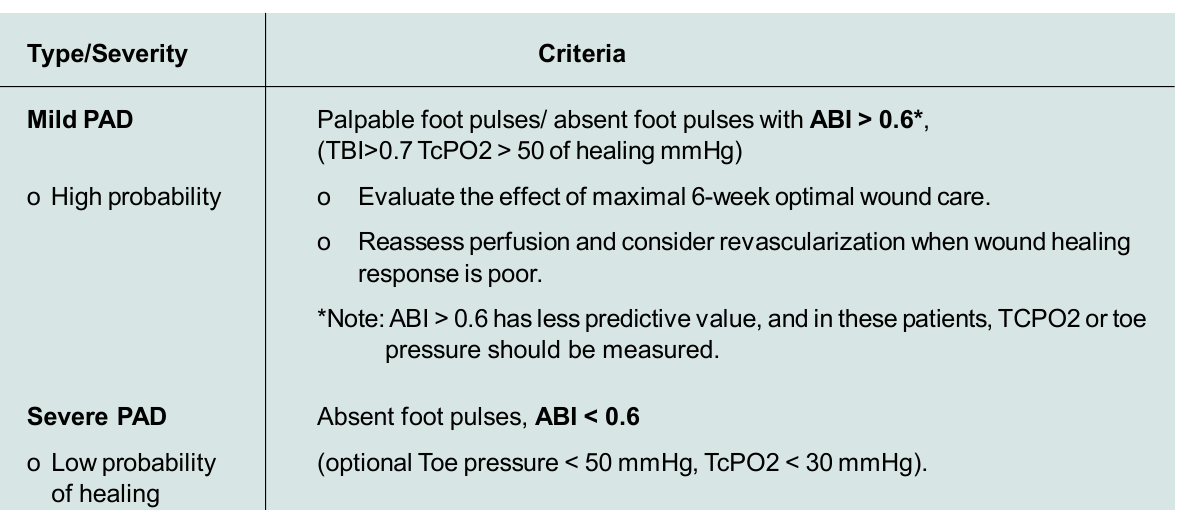
Table 4. Severity of peripheral artery disease